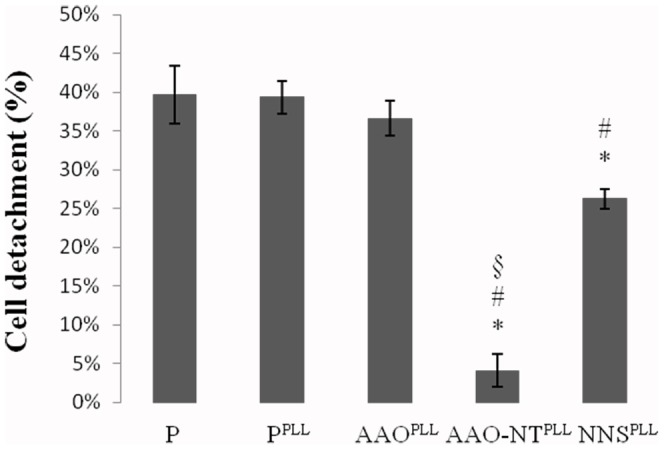
Cell detachment percentage after 50 mM EDTA and ultrasounds treatment on P, PPLL, AAOPLL, AAO-NTPLL and NNSPLL, N = 6.ANOVA followed by Bonferroni analysis, p = 0.